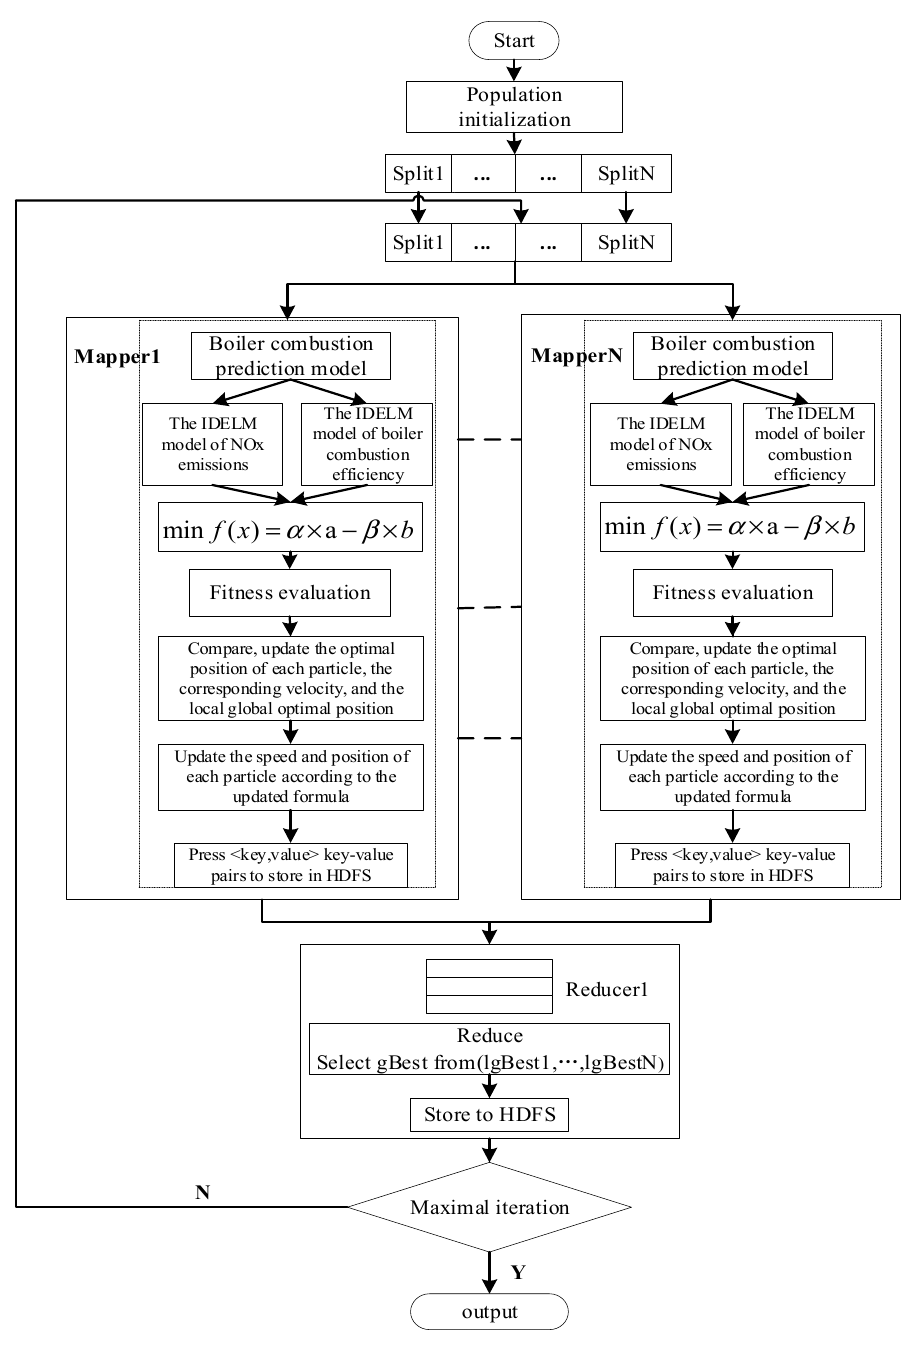
Figure 9. Boiler combustion optimization by MR-PSO Algorithm.